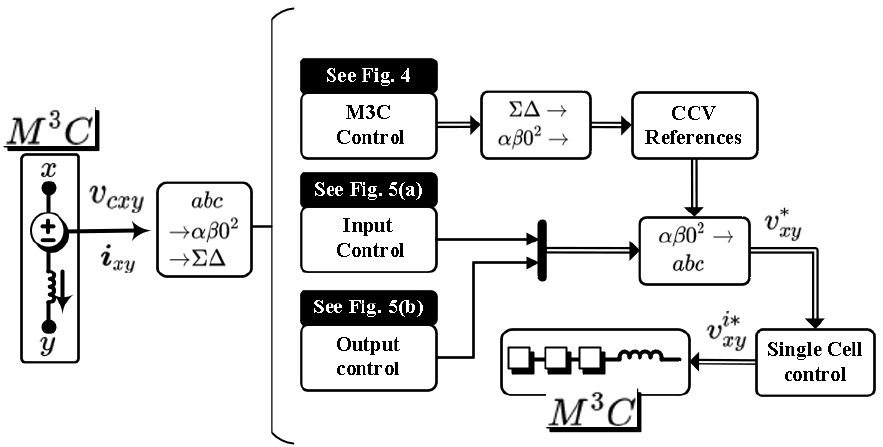
Figure 3. Overview of the control system of the M 3 C topology in Equal Frequencies Mode